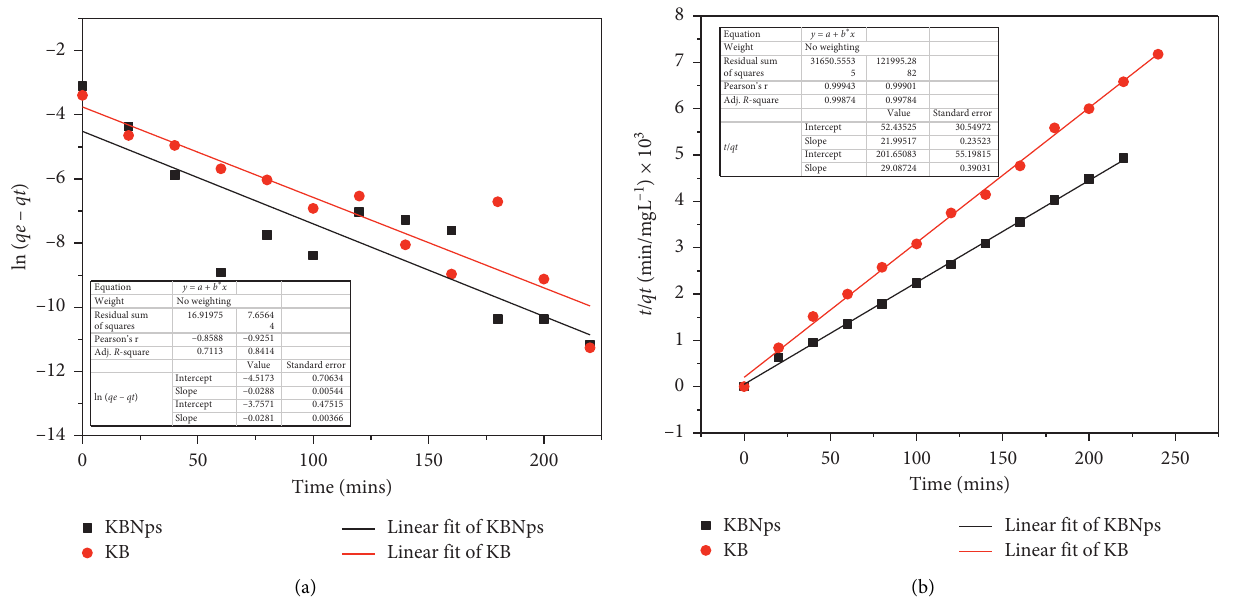
Figure 6: The kinetic models for KB and KBNPs adsorptions: first order (a) and second order (b).